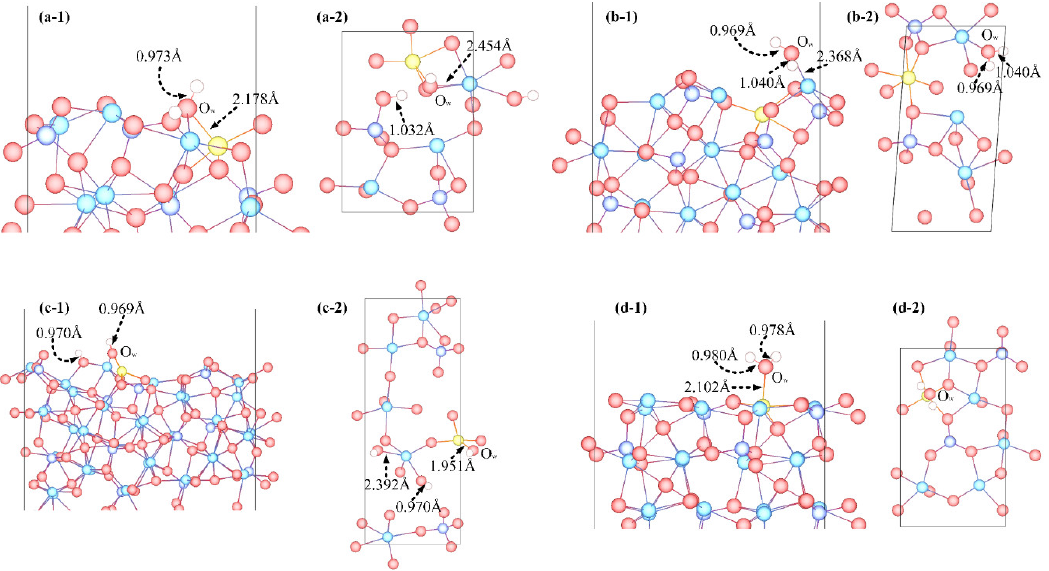
Figure 2. Water adsorption configuration of: ( a ) dissociative adsorption on the β-C 2 S (100) surface, ( b )